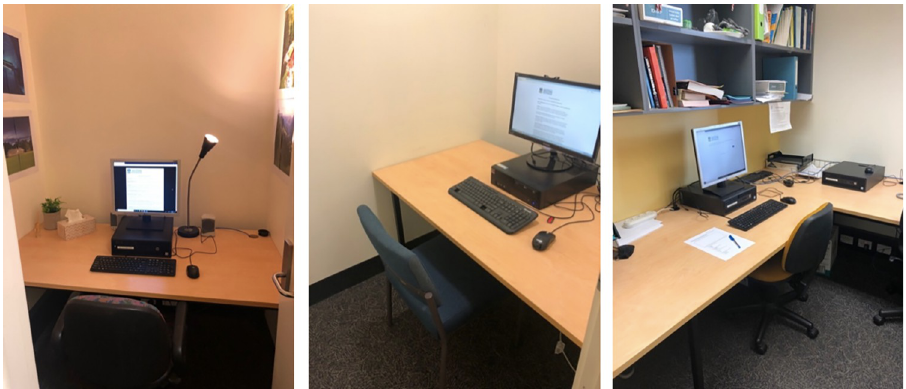
Fig 1. Rooms used in Experiment 1. Left: Room A; middle: Room B; right: Room C.